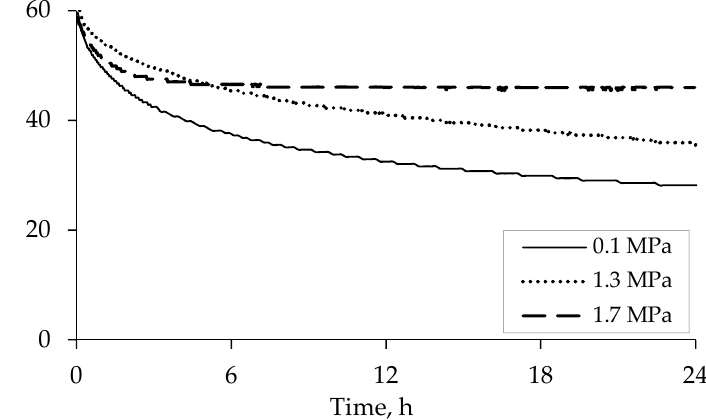
Figure 13. Time-dependent hydrate saturation in frozen sand 3 samples after the pressure dropped to 0.1, 1.3, and 1.7 MPa at −6 °С .